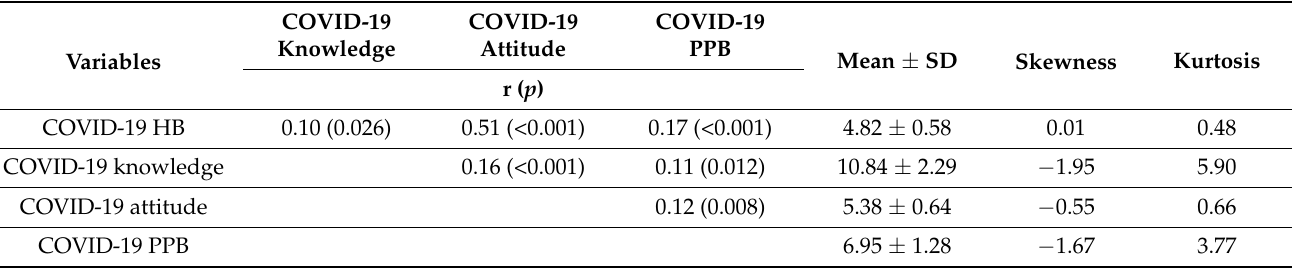
Table 3. Correlation between COVID-19 Health Belief, Knowledge, Attitude, and Practice of Preven- tion Behavior ( n =